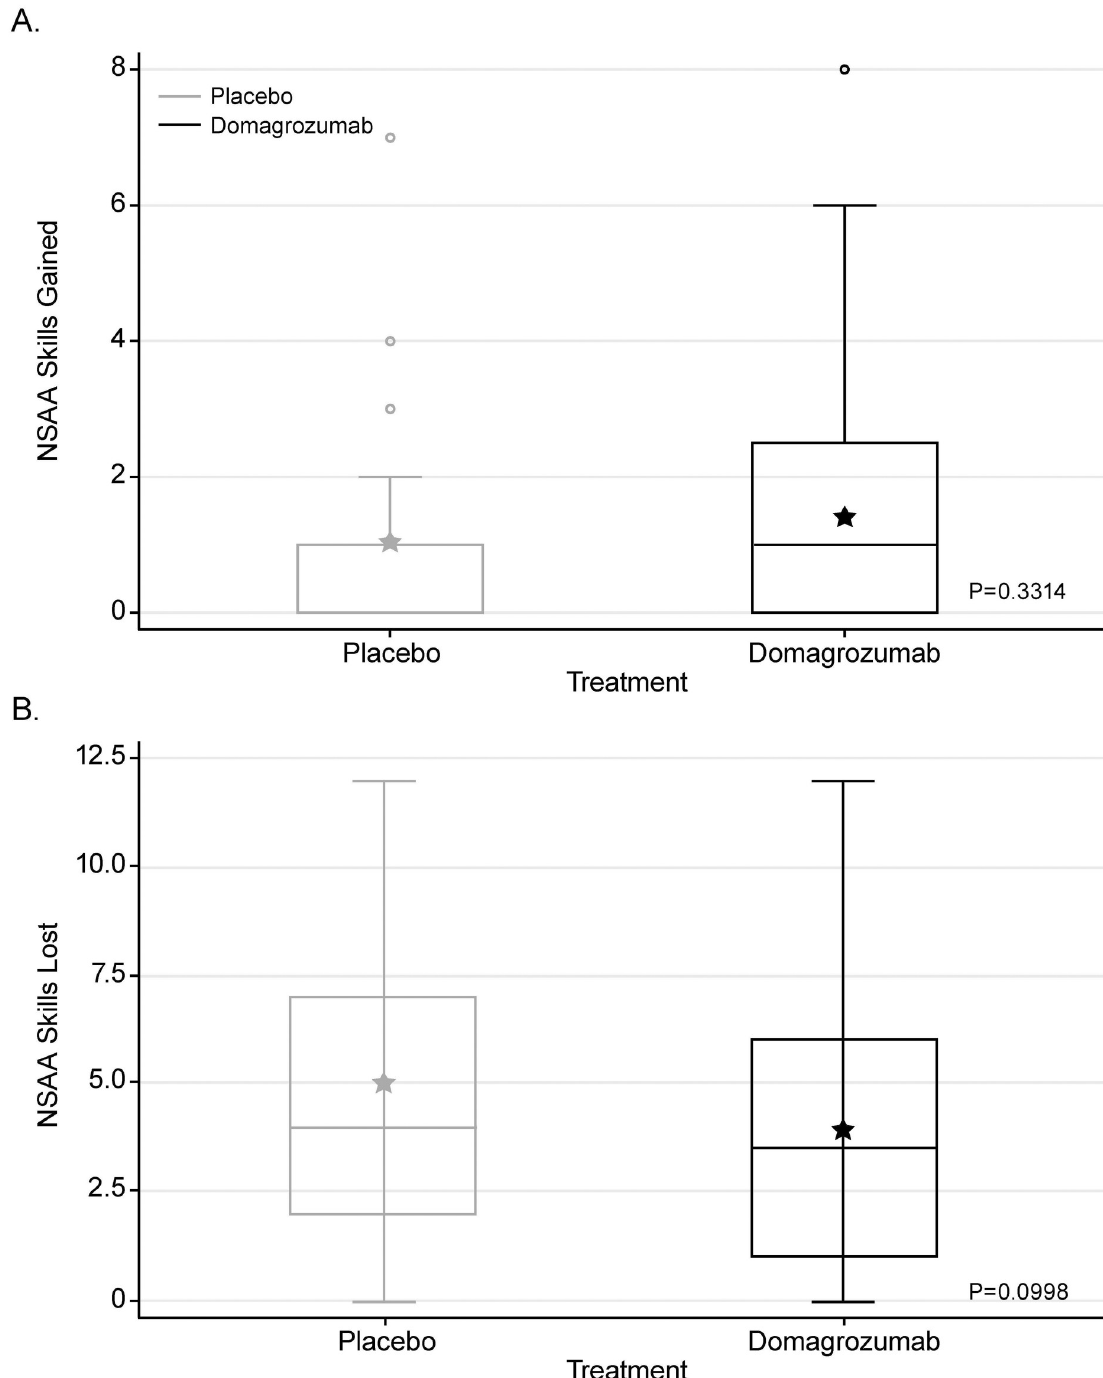
Fig 4. Cumulative number of skills (A) gained or (B) lost, through week 49, in domagrozumab- vs. placebo-treated patients. Data are median [1st and 3rd quartiles]. The stars represent the mean and the circles are the outliers. NSAA, North Star Ambulatory Assessment.